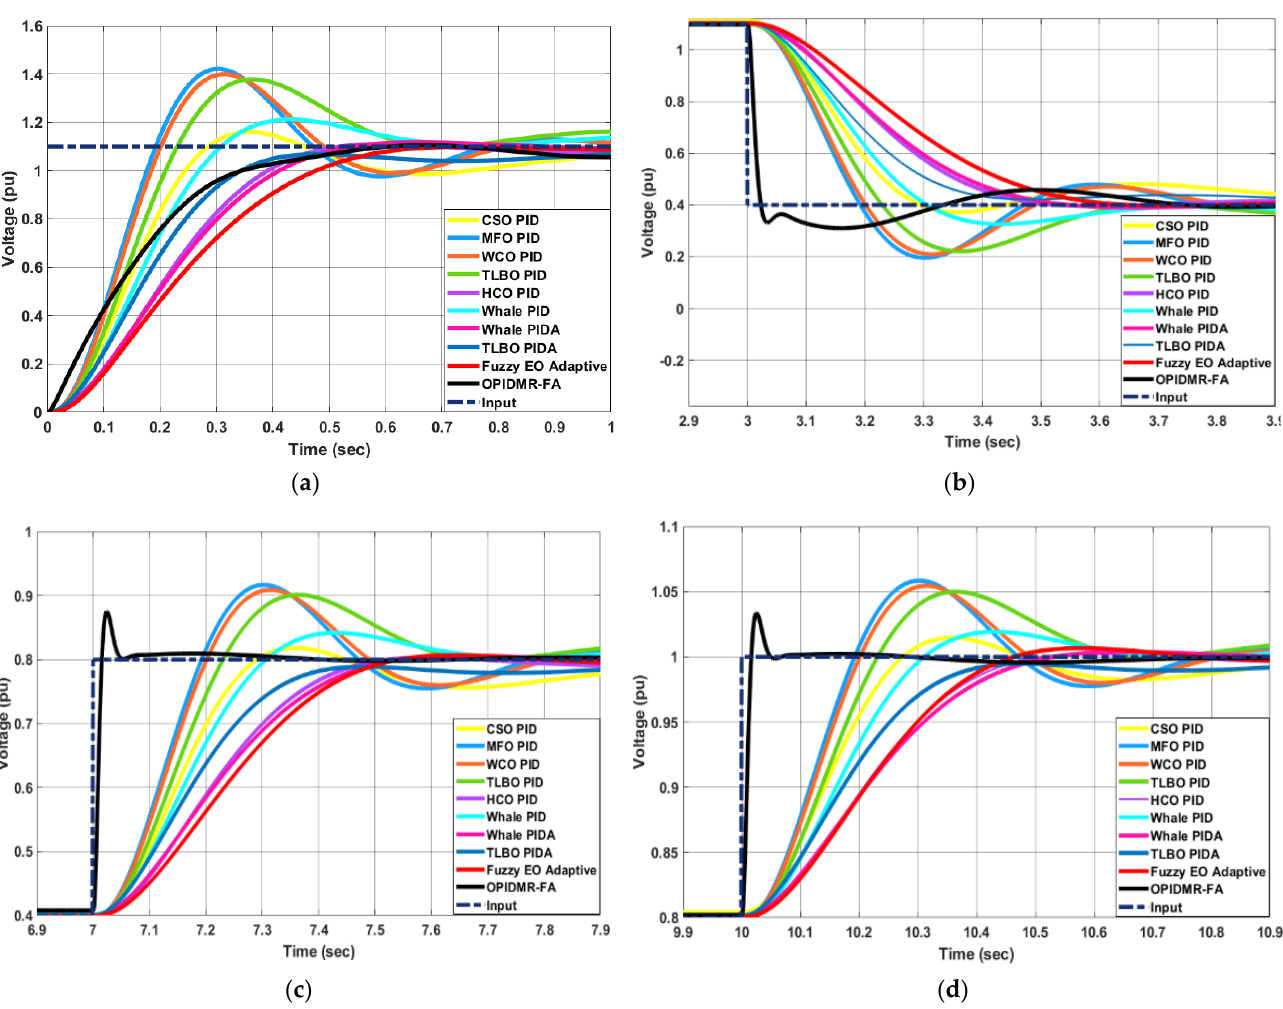
Figure 14. Magnified views of Figure 13: ( a ) the first change, ( b ) the second change, ( c ) the third change, and ( d ) at the fourth change.